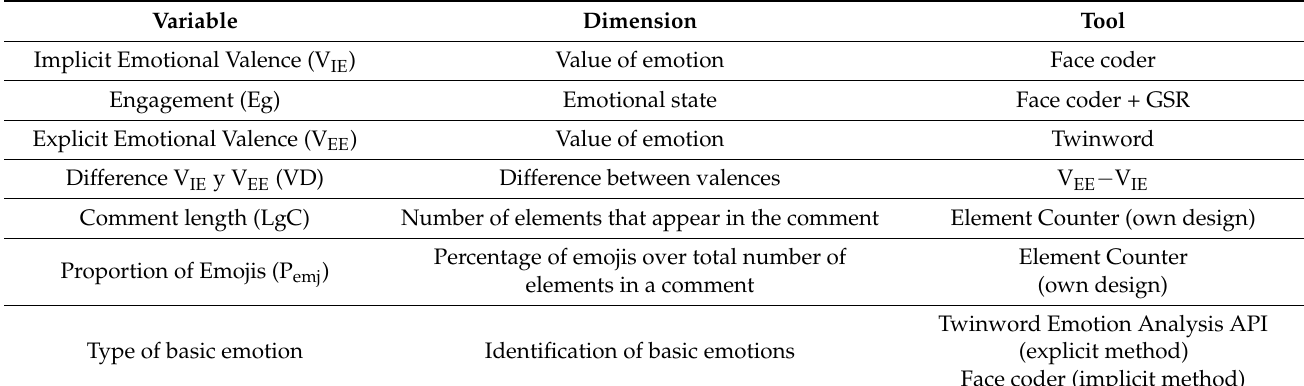
Table 3. Variables, dimensions and tools of Phases 1 and